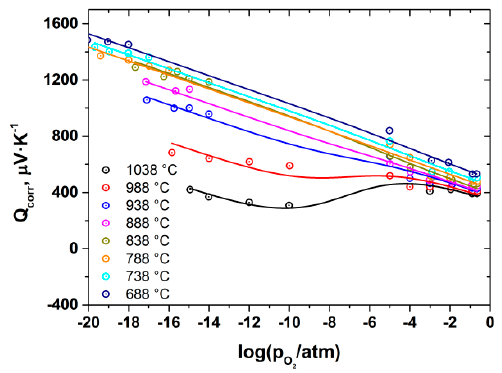
Figure 5. Normalized Seebeck coefficient of BZY10 vs. p O 2 at log( p H 2 O/atm) = − 1.73. Points-experimental data, lines-result of the fit of Equation (5).